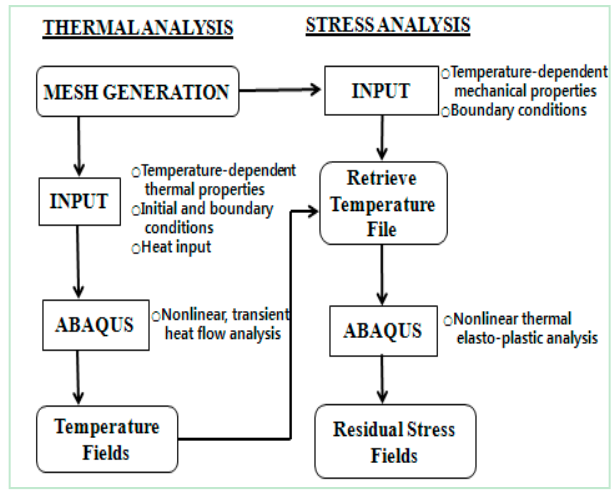
Figure 3. Numerical analysis procedure for the uncoupled thermo-mechanical analysis [21].